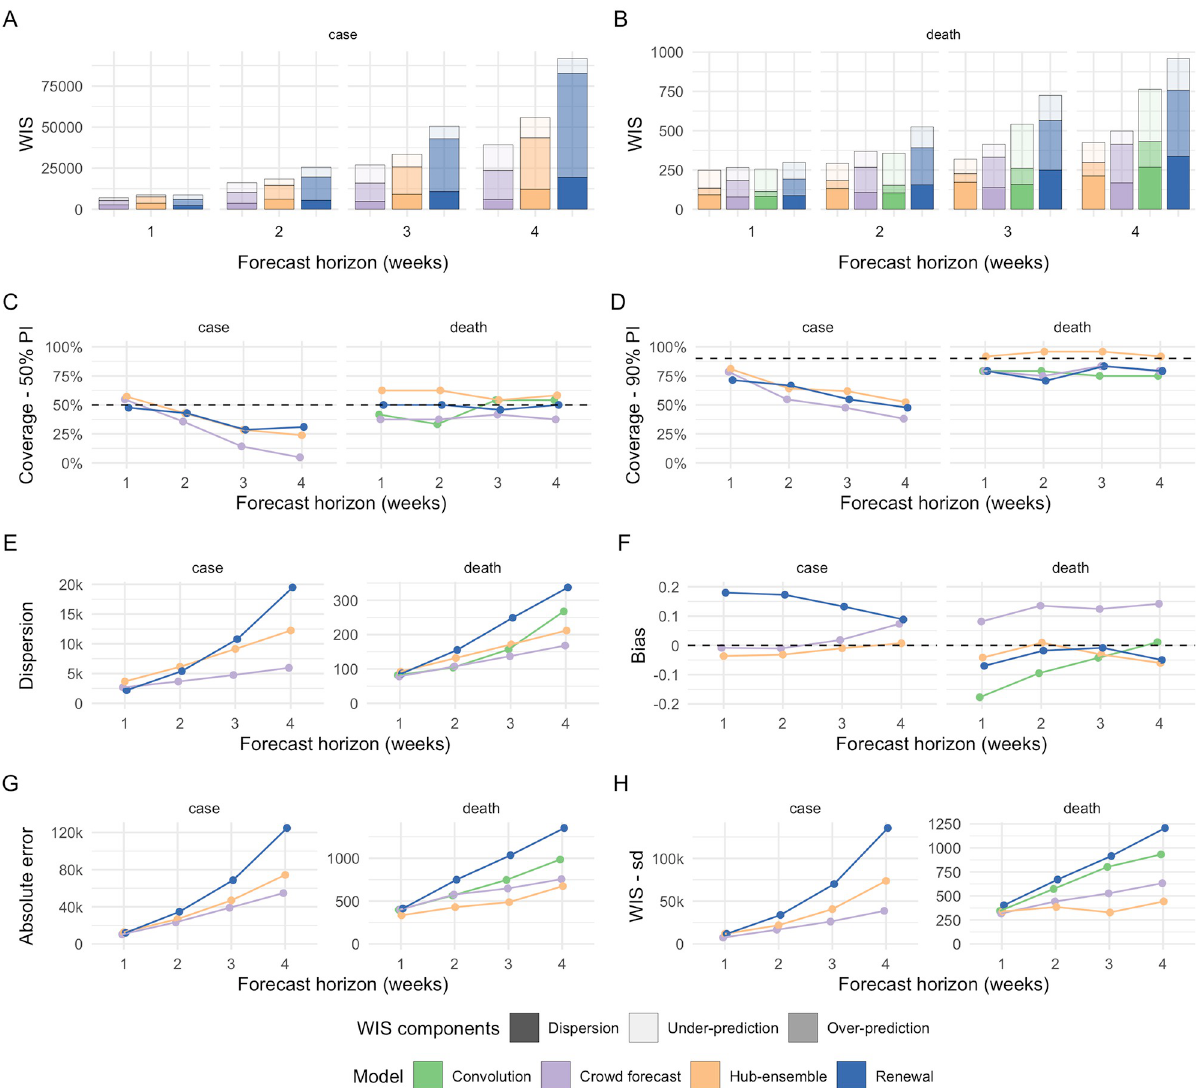
Fig 1. Visualisation of aggregate performance metrics for forecasts one to four weeks into the future. A, B: mean weighted interval score (WIS, lower indicates better performance) across horizons. WIS is decomposed into its components dispersion, over-prediction and under-prediction. C: Empirical coverage of the 50% prediction intervals (50% coverage is perfect). D: Empirical coverage of the 90% prediction intervals. E: Dispersion (same as in panel A, B). Higher values mean greater dispersion of the forecast and imply ceteris paribus a worse score. F: Bias, i.e. general (relative) tendency to over- or underpredict. Values are between -1 (complete under-prediction) and 1 (complete over-prediction) and 0 ideally. G: Absolute error of the median forecast (lower is better). H. Standard deviation of all WIS values for different horizons.